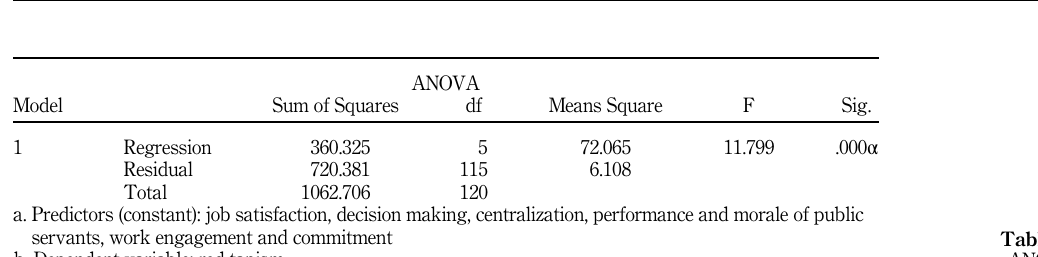
Table 5. Summary of the model